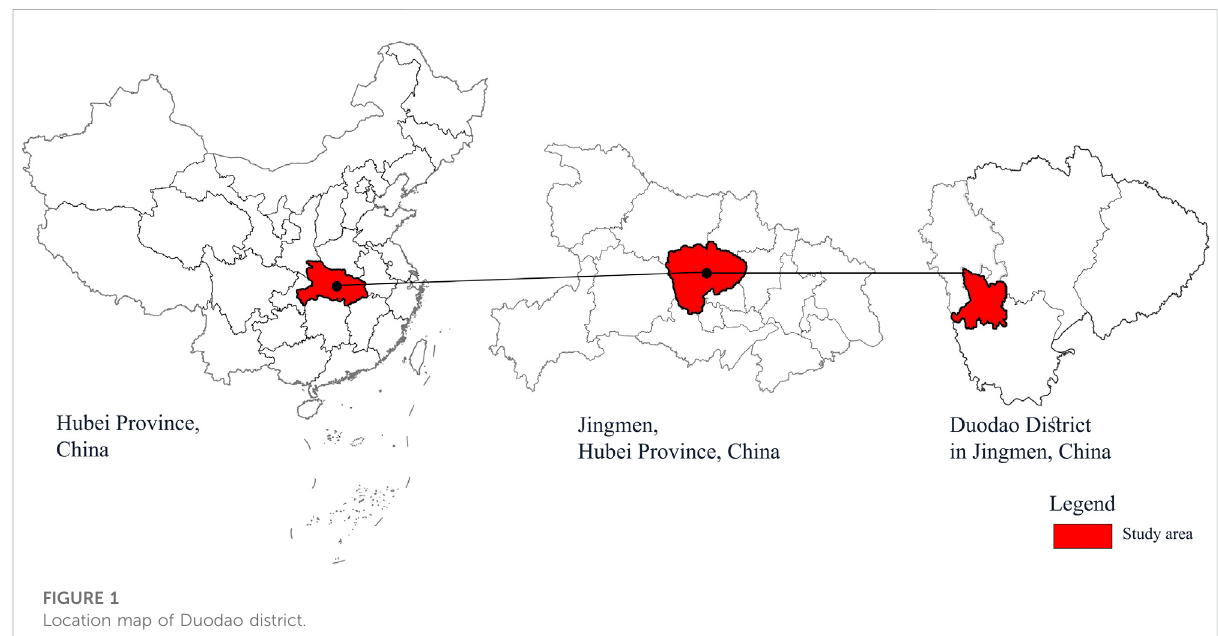
FIGURE 1 Location map of Duodao district.